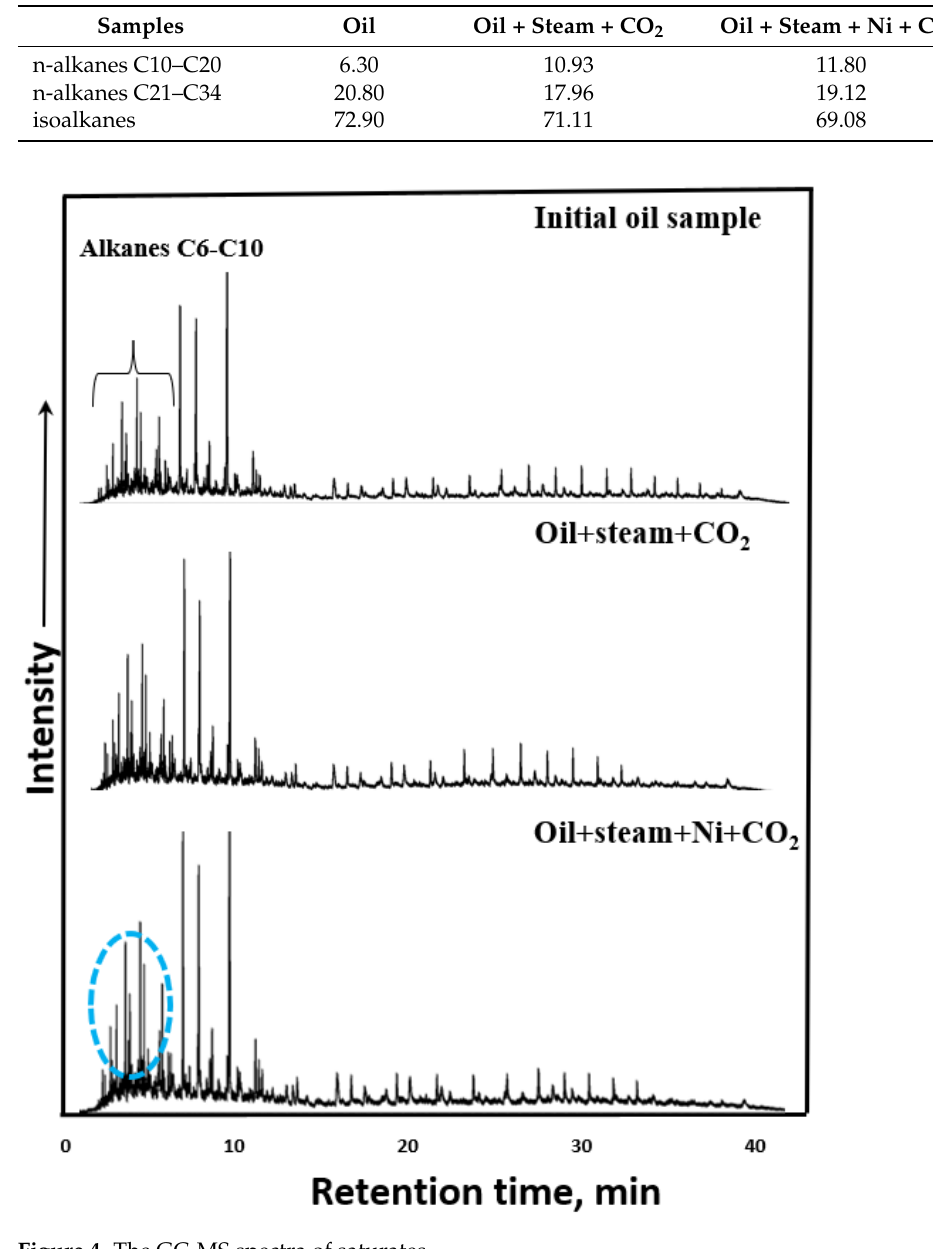
Figure 4. The GC-MS spectra of